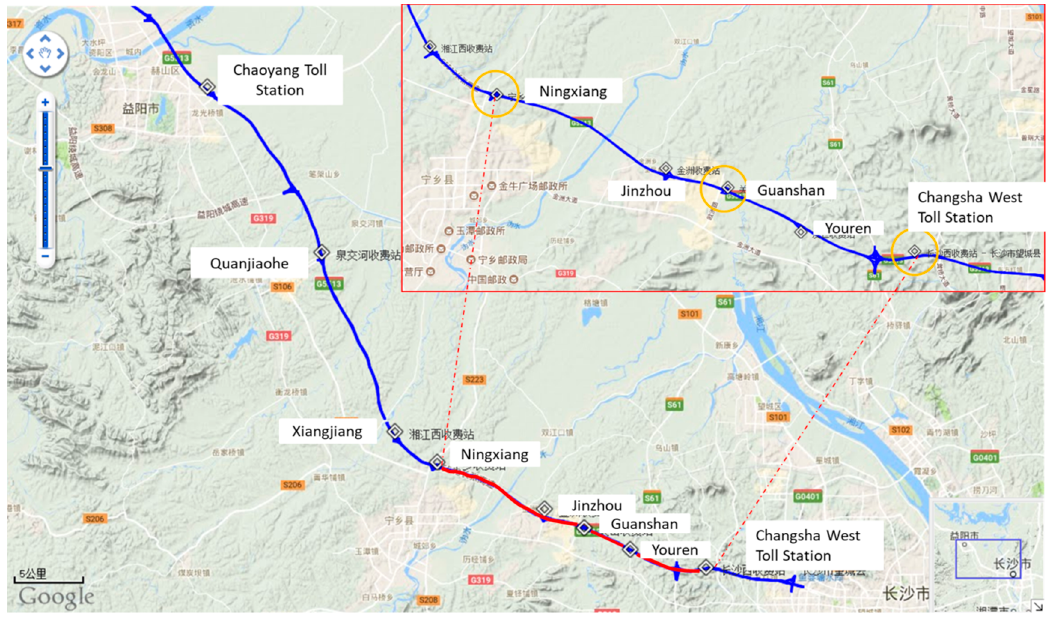
Figure 1. Layout of Freeway G5513 and toll stations.